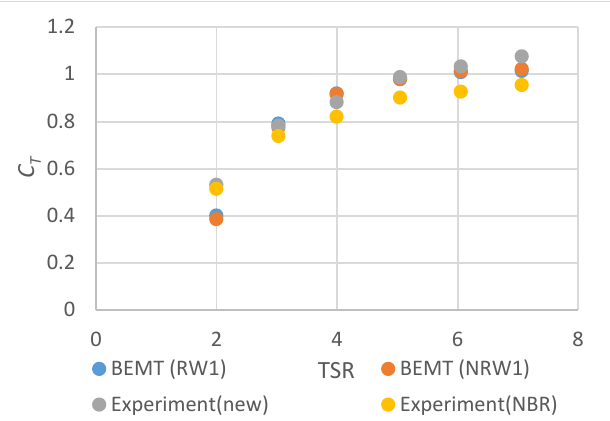
Figure 21. C T comparison between modified BEMT calculations and modified experimental data under wave-current interactions with a wave height of approximately 0.19m and an apparent wave period of 0.7s.